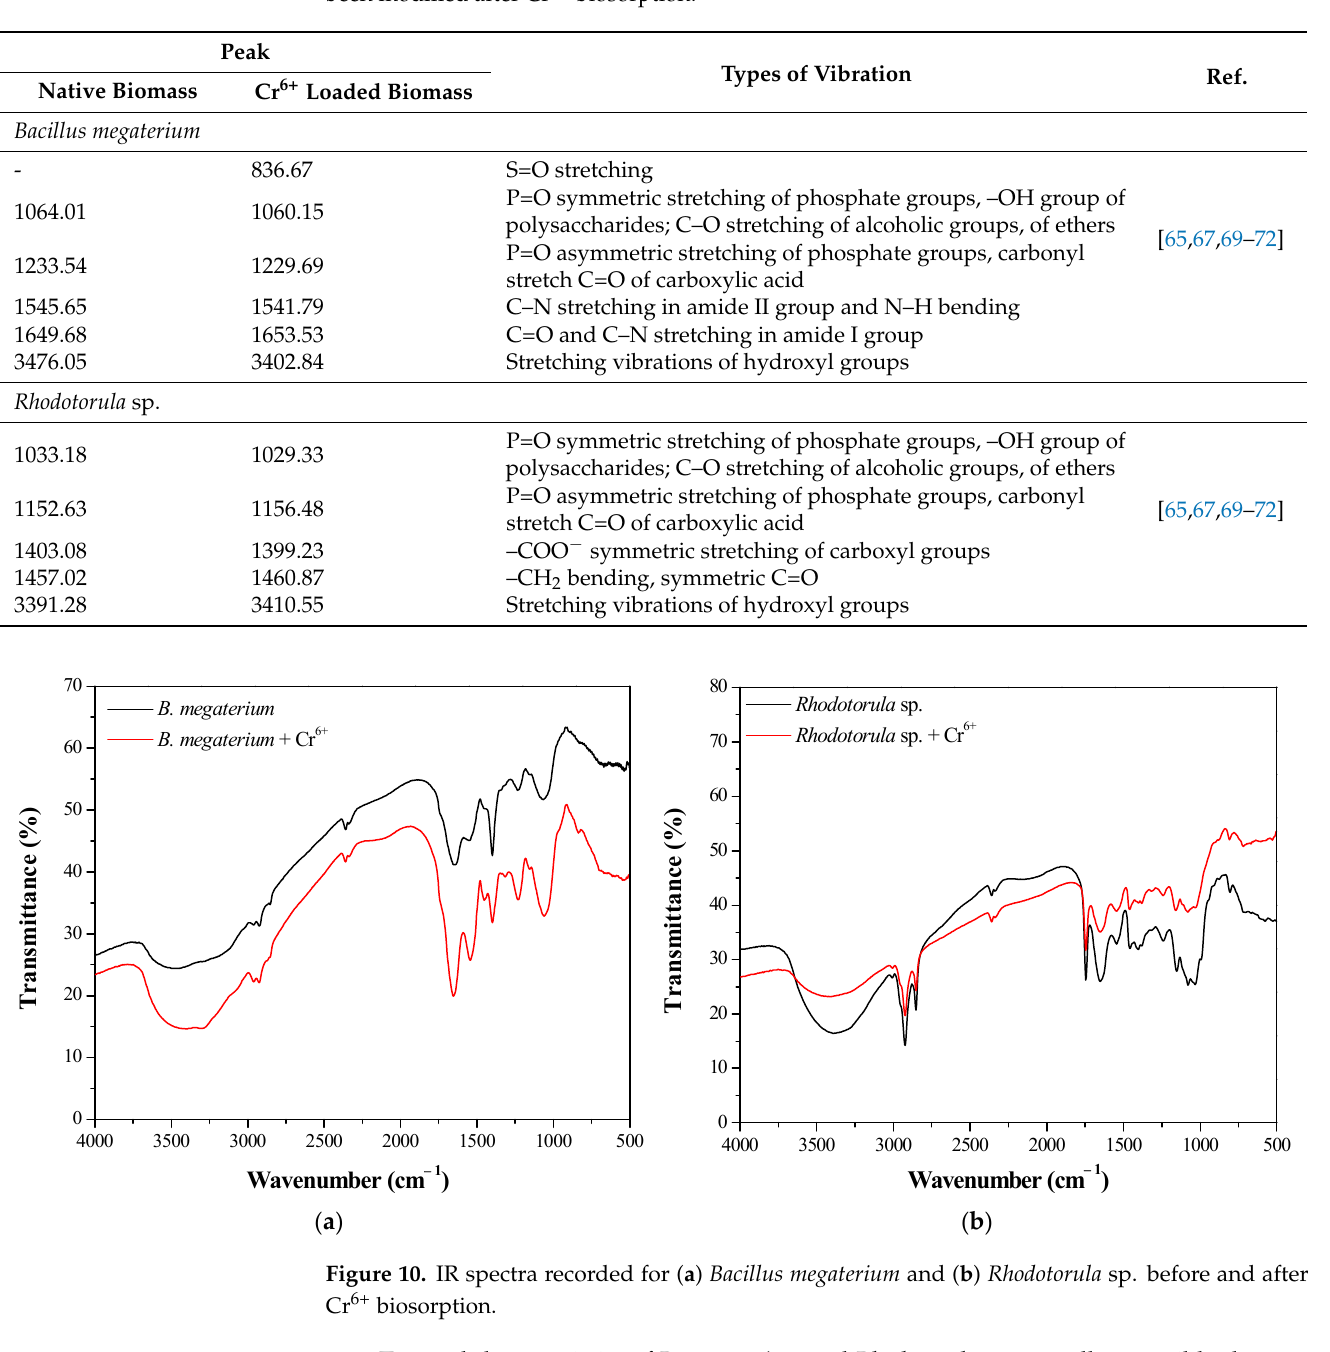
According to Petrovi´c et al. [68] these changes may be due the possible complexation process. Table 5. IR absorption peaks of the functional groups identified on the biosorbents surface that have been modified after Cr 6+ biosorption.